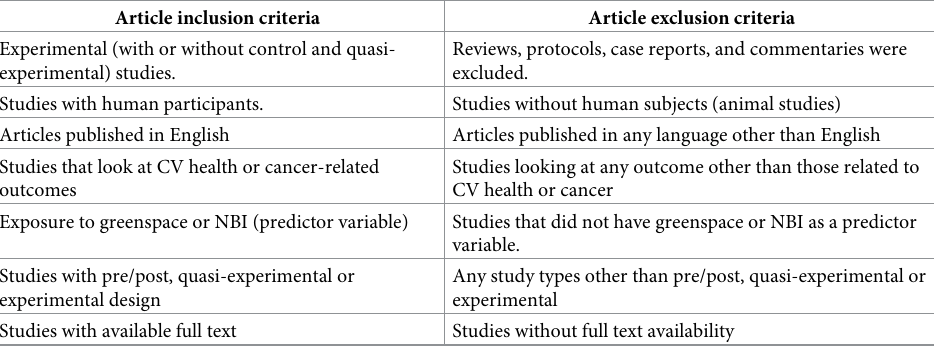
Table 1. Inclusion and exclusion